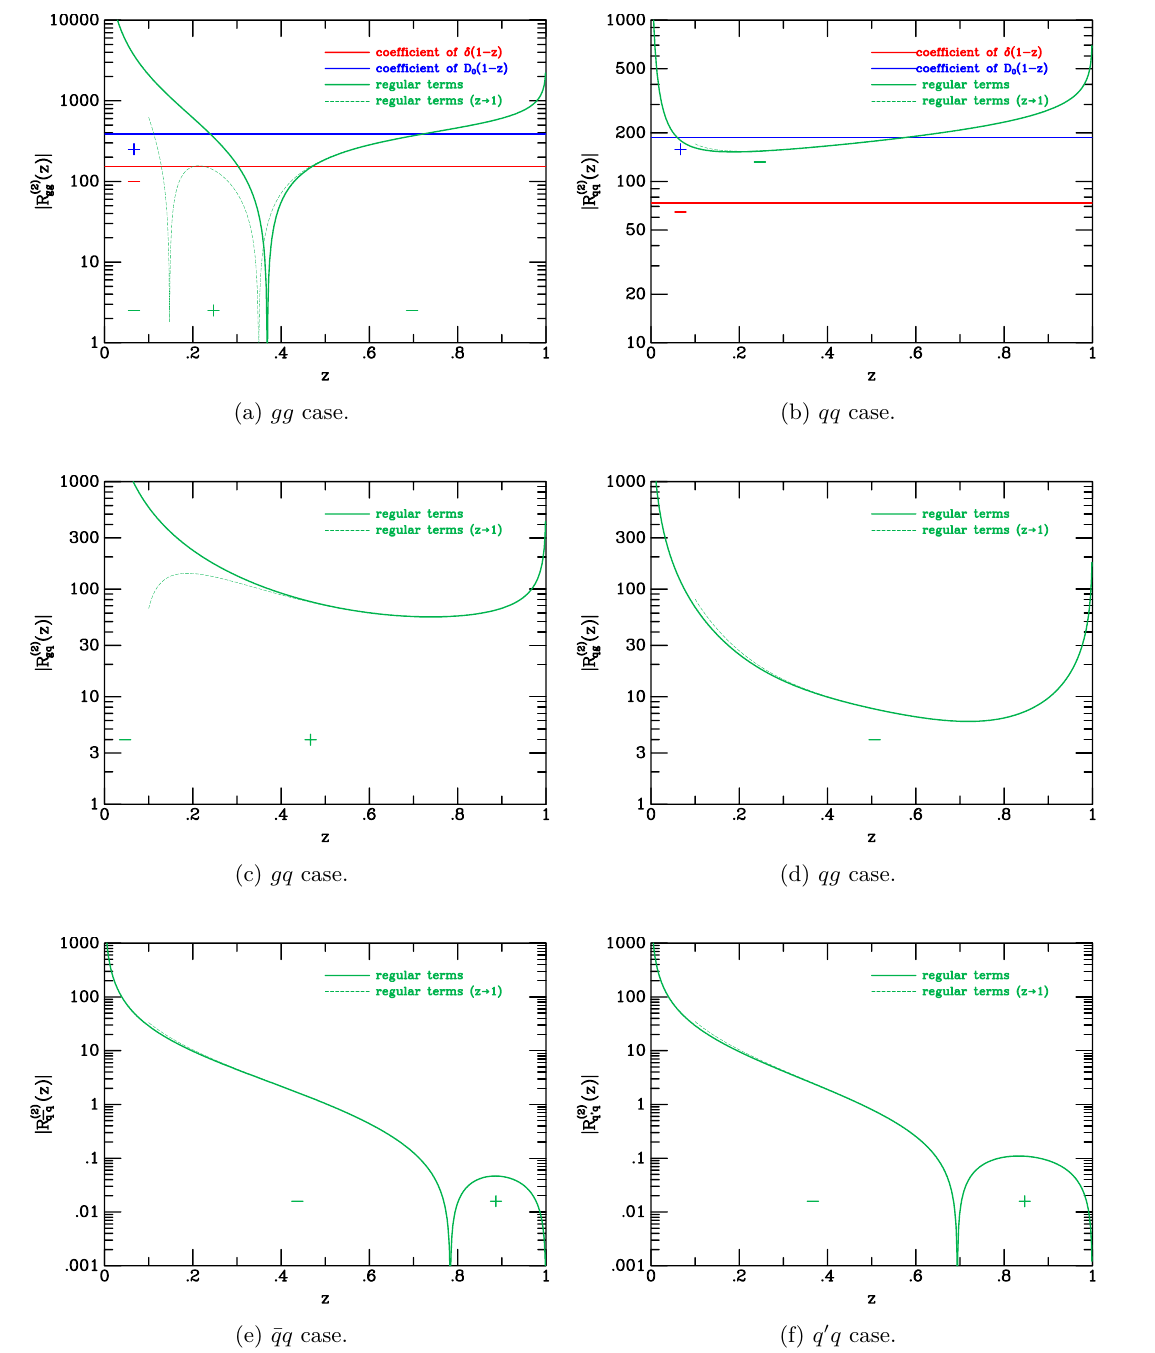
Figure 19 . Absolute value of R (2) for jet measure R = 0 . 5 . The ¯ q 0 q case is the same as the q 0 q case. The sign of the contribution in the various regions is